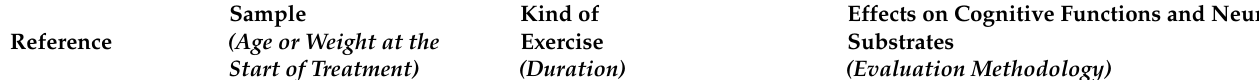
Table 5. Studies on water activity effects on cognitive functions and neural substrates of healthy